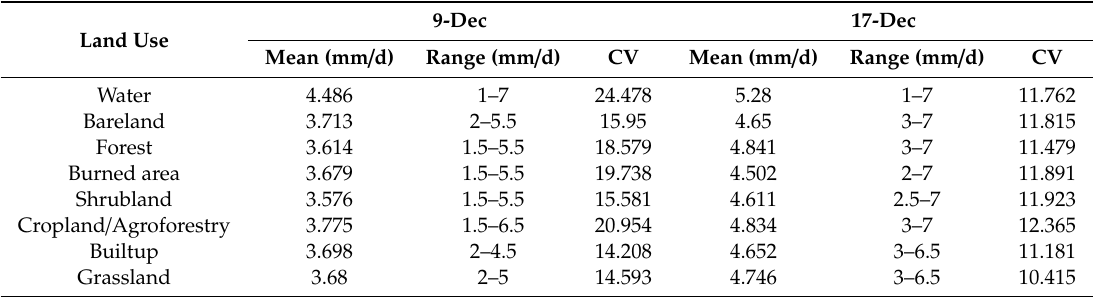
Table 5. Mean actual evapotranspiration (ET), range, and coe ffi cient of variation (CV) by land use / cover types at Tono